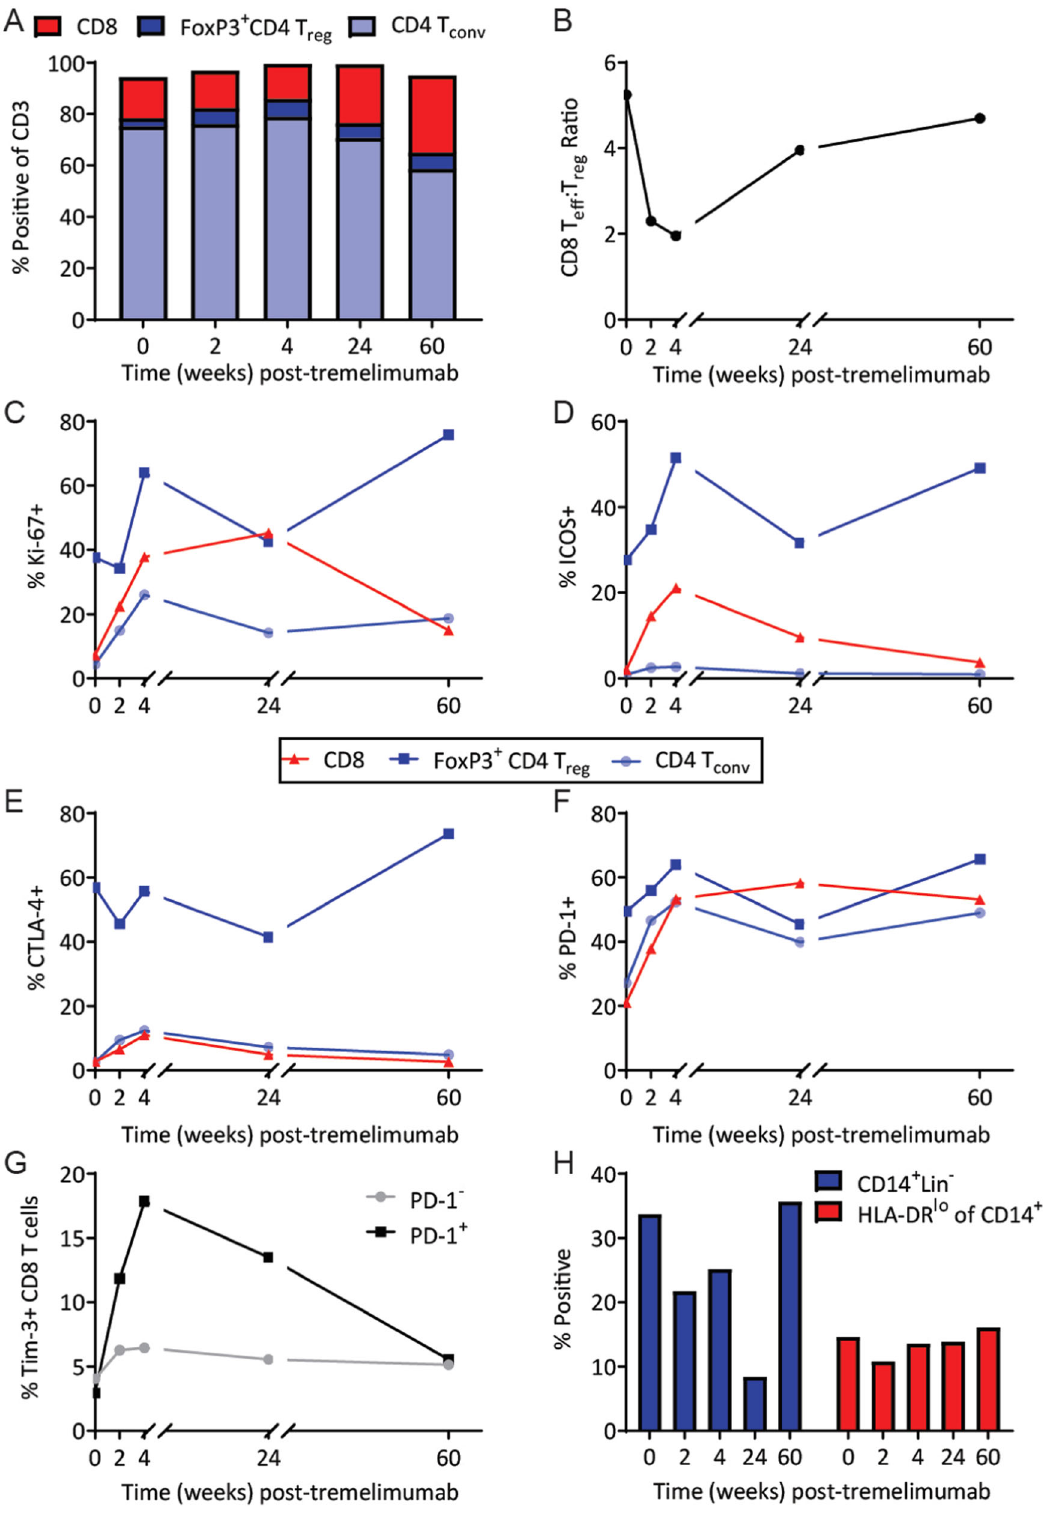
Fig. 4 Immunologic correlates in the blood of a HER2 + responder. Peripheral blood mononuclear cells were stained for various markers and analyzed using fl ow cytometry at weeks 0, 2, 4, 24, and 60 post-treatment initiation ( n = 2, technical replicates). A Expression of CD8 (red), FoxP3 − CD4 conventional T cells (T conv ; light blue), and FoxP3 + CD4 regulatory T cells (T reg ; dark blue) out of total CD3 + live cells. B CD8:T reg ratio. (C-F) CD8 (red triangles), CD4 T conv (light blue circles), and T reg (dark blue squares) were analyzed for expression of ( C ) Ki-67, ( D ) ICOS, ( E ) CTLA-4, and ( F ) PD-1. G Tim-3 expression on PD-1 + compared to PD-1 − CD8 T cells. H Percentage of CD14 + and HLA-DR lo monocytes over